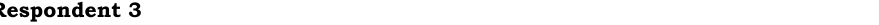
Table 2. Answers from the interview